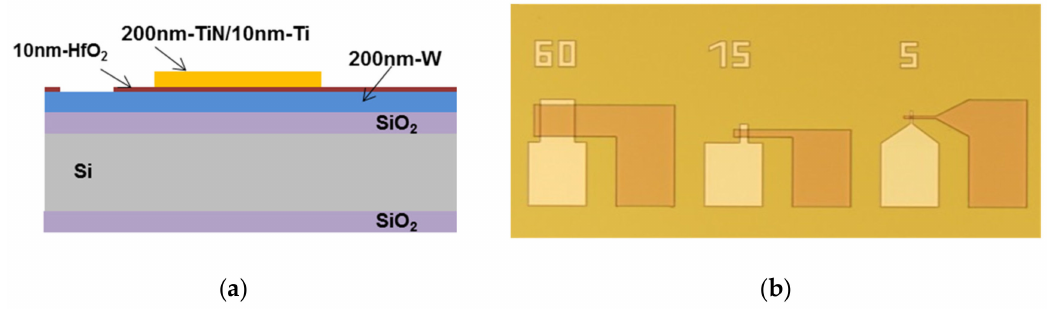
Figure 8. ( a ) Schematic device cross-section; ( b ) Top view optical microscope image of the fabricated